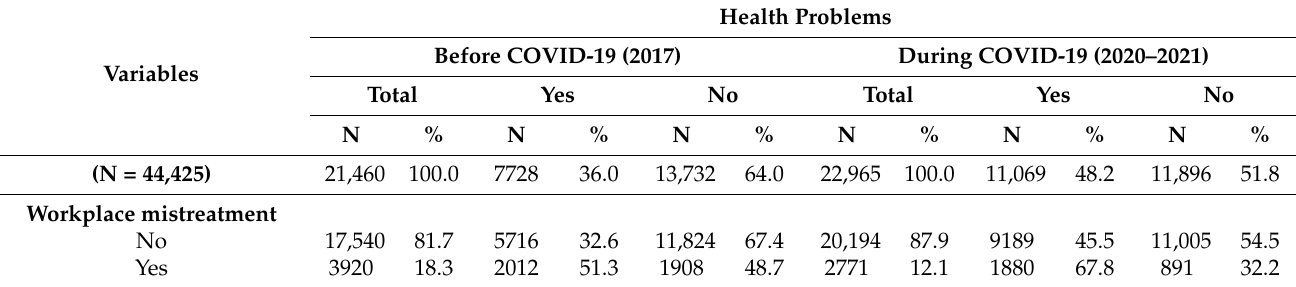
Table 1. General characteristics of the study